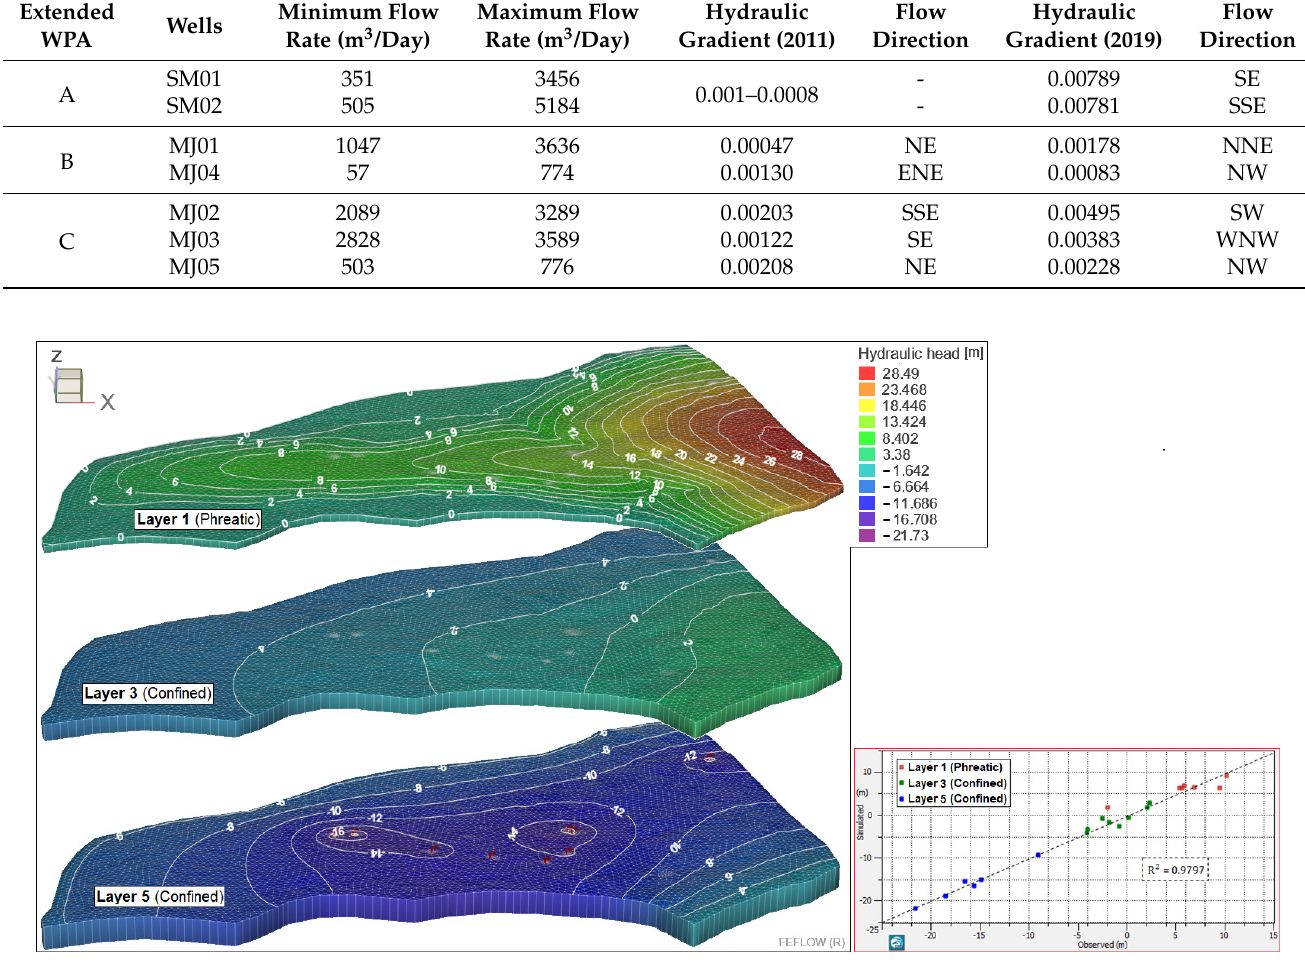
Figure 7. Groundwater flow model and calibration values. Table 2. Boundary conditions applied in the numerical model; BC is Boundary Condition; means not applied; is applied.